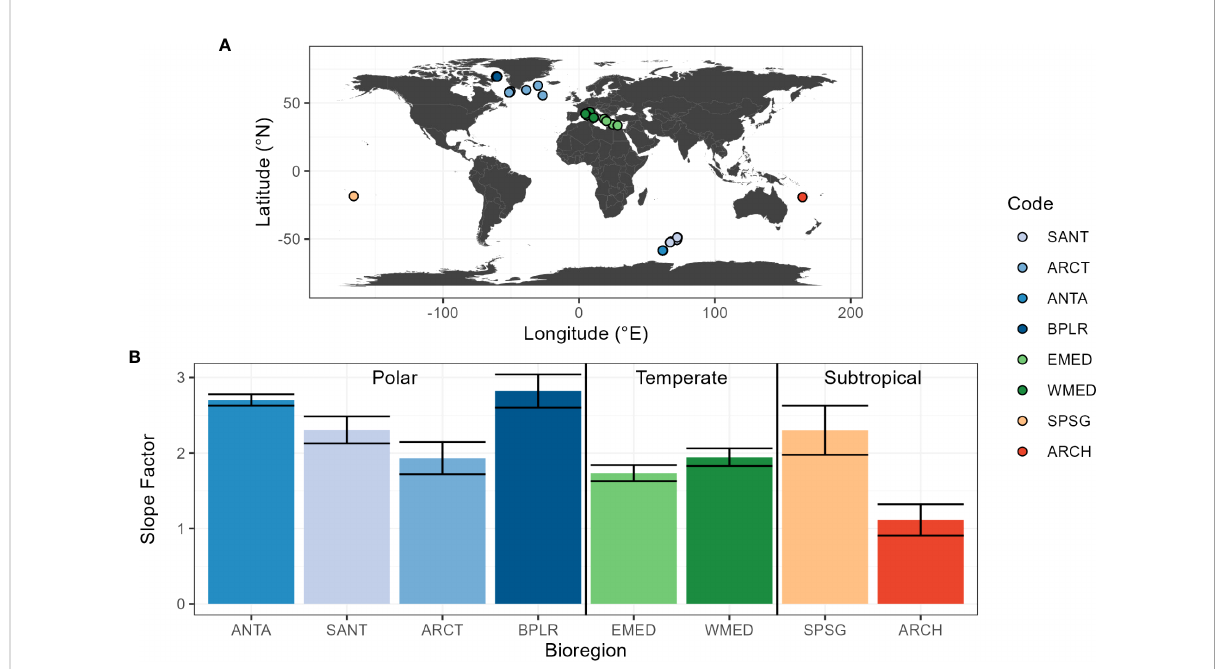
FIGURE 1 (A) Geographic location of the sampling stations in the Glo-Argo database and (B) mean value of the slope factor, de fi ned as the coef fi cient of the regression between [Chla] Fluo and [Chla] HPLC , for each bioregion of the Glo-Argo database (ANTA, Antarctic Province; ARCH, Archipelagic Deep Basin Province; ARCT, Atlantic arctic Province; BPLR, Boreal Polar Province; EMED, Eastern Mediterranean Sea; SANT, Subantarctic Province; SPSG, South Paci fi c Subtropical Gyre Province; WMED, Western Mediterranean Sea). The error bars indicate 95% con fi dence